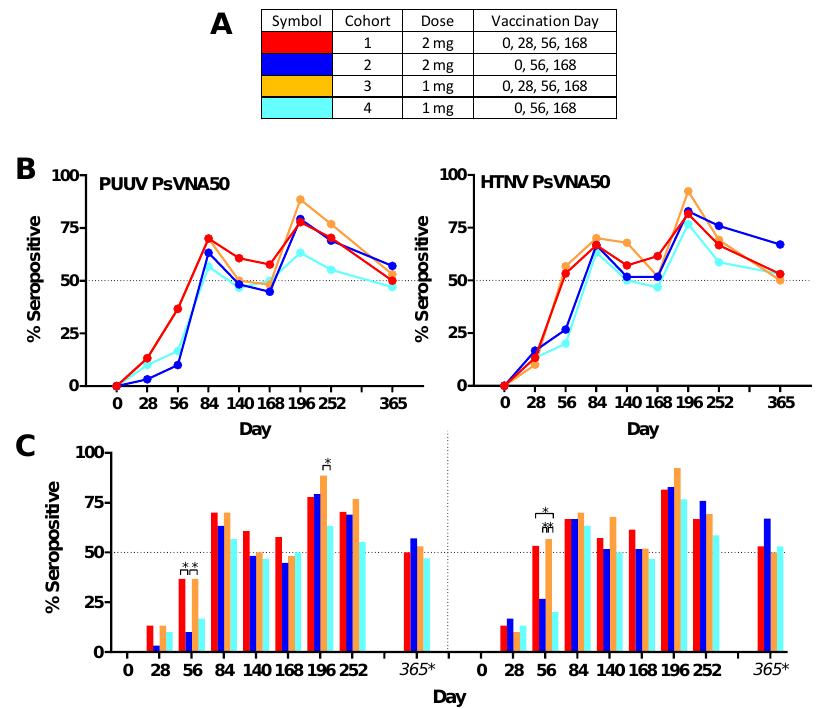
Figure 3. Anti-PUUV and anti-HTNV PsVNA50 seropositivity rates. ( A ) Legend. ( B ) PUUV and HTNV seropositivity rates for each cohort presented as line graphs. Percentages are based on the number of subject presenting non-missing data. ( C ) The same data plotted as bar graphs to highlight significant differences between groups. Percentages are based on the number of subject presenting non-missing data except Day 365. The only subjects who returned for Day 365 were the subpopulation that was still seropositive on the Day 252 visit. For Day 365 the percentage is based on the full cohort size of 30. * p -values from pairwise two-sided Fisher’s exact tests.